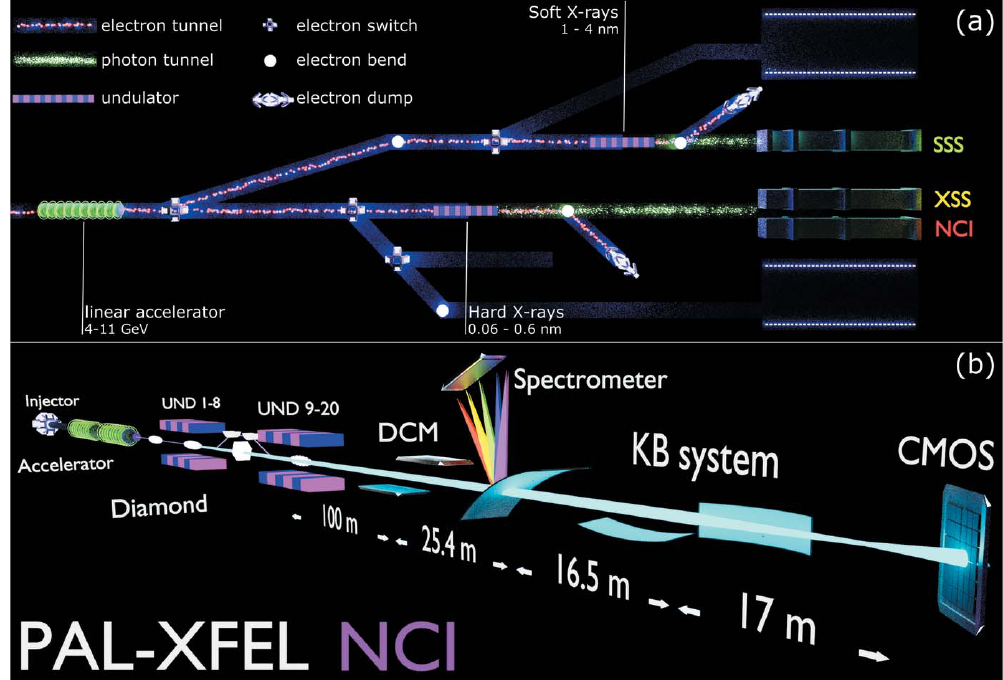
Figure 1 Schematic image of the experimental set-up. ( a ) The general outline of the PAL-XFEL facility. ( b ) An outline of the NCI beamline at PAL-XFEL. For the SASE radiation, 20 undulator sections were used. In the self-seeding mode of operation, the diamond crystal between the eighth and ninth sections of the undulator was